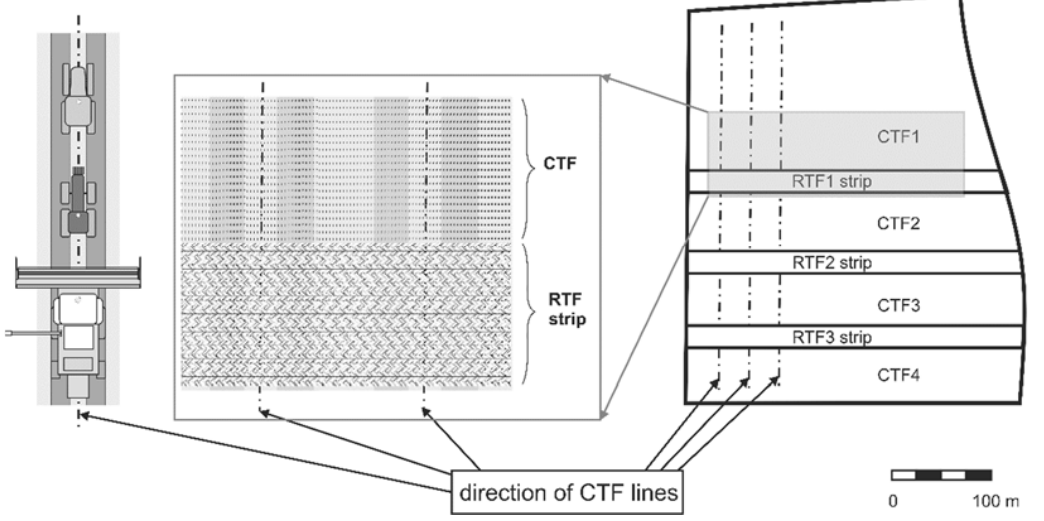
Figure 2. Tramlines (size in meters) of used machines without adaptation of track width (CTF— experimental field in Kolinany).